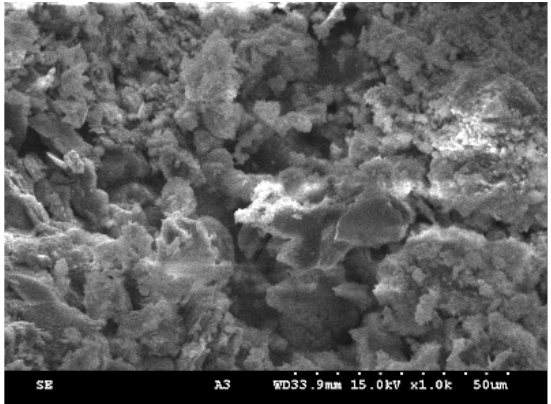
Figure 11. SEM photo of the specimens containing 1.2% fiber and 40%